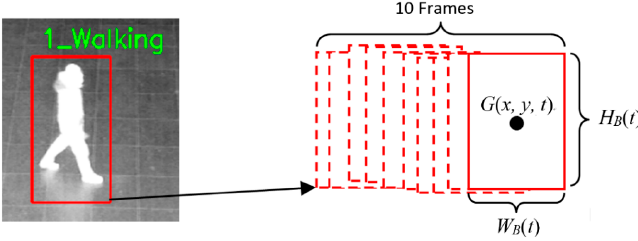
Figure 5. Example showing the parameters used to analyze the detected human box by comparing the box in the current frame with those in the previous nine